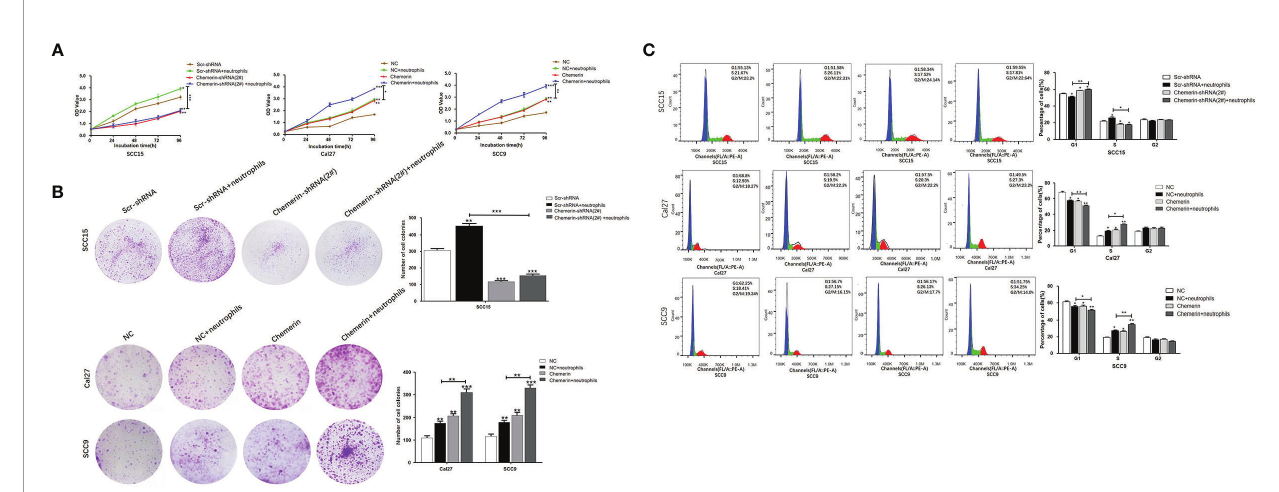
FIGURE 5 | Neutrophils promote cell proliferation through Chemerin. (A) Cell growth was analyzed using the MTT assay. Absorbance of 490 nm was measured. The data were presented as the means of six separated experiments, each performed in triplicate. (B) Colony formation in each group was photographed and colony numbers were illustrated in histogram. (C) Flow cytometry revealed the distribution of cell phases in the OSCC cell lines. Data were shown as mean ± SD from three independent experiments (* P < 0.05; ** P < 0.01; *** P <